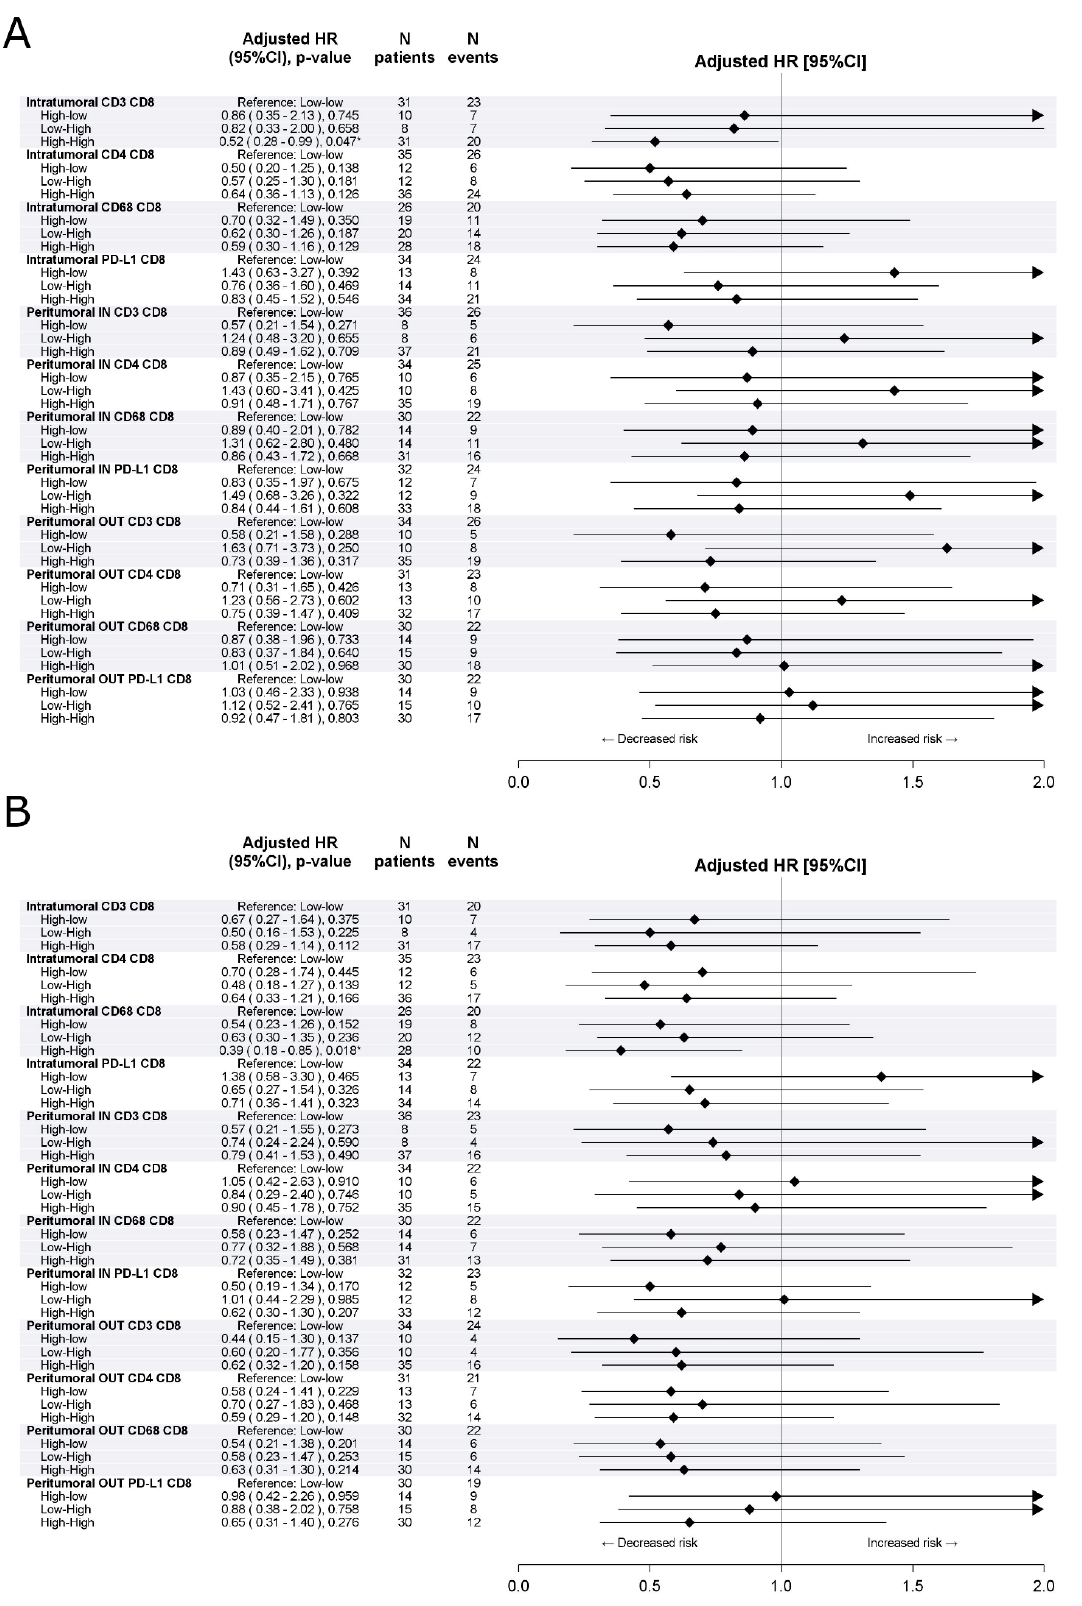
Figure 2. Effect of combination with CD8+ density on disease free survival ( A ) and overall survival ( B ) in the training cohort. Multivariable Cox proportional hazard models. * indicates significant p -value at 0.05